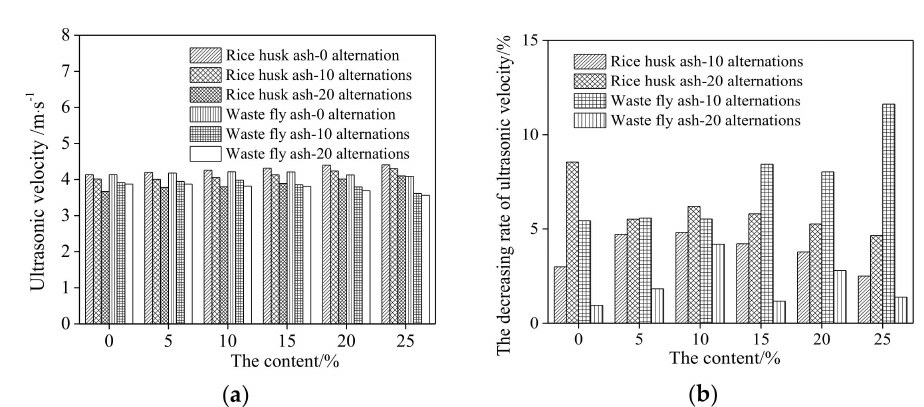
Figure 7. The ultrasonic velocity of RPC and the following increments during NaCl dry–wet alterna- tions. ( a ) The ultrasonic velocity. ( b ) The increasing rate of ultrasonic